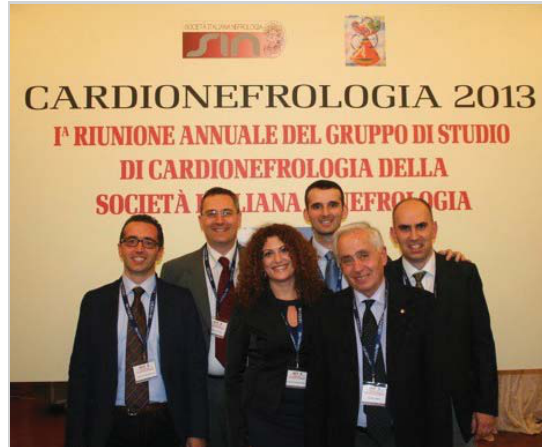
Figure 1. Cardionephrology Study Group of the Italian Society of Nephrology. (First line from left to right: Antonio De Pascalis, Emiliana Ferramosca, and Mario Timio; second line from left to right: Rodolfo F. Rivera, Antonio Bellasi and Luca Di